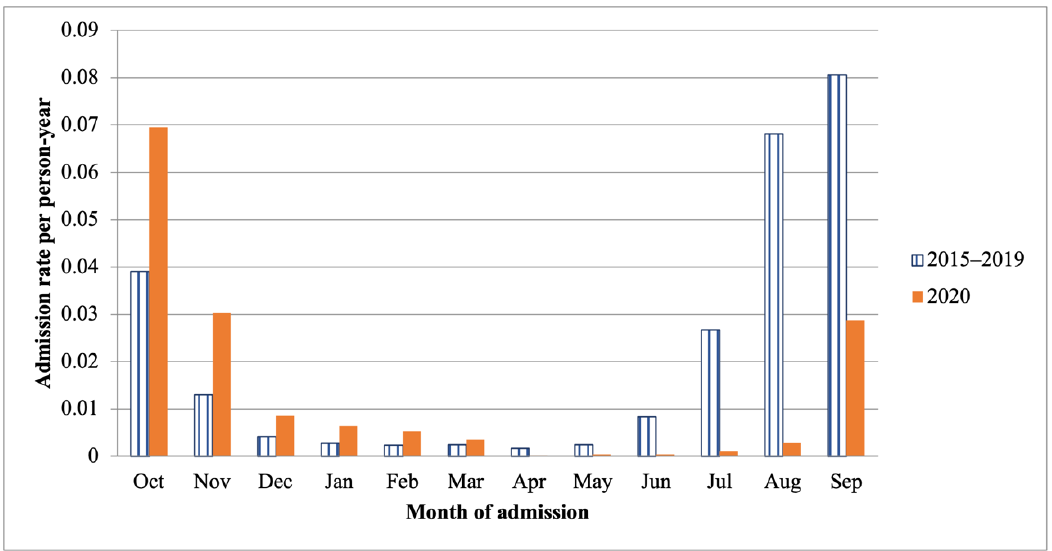
Figure 2. Comparing the admission rate per person year for children with RSV-related LRTI be-